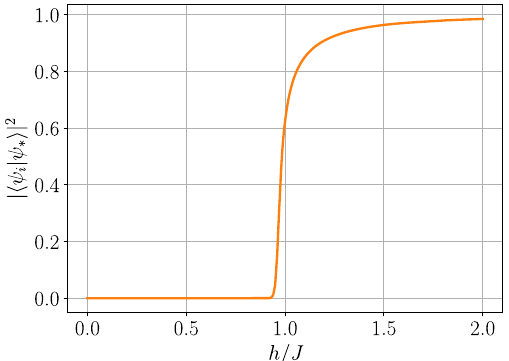
FIG. 4. LMG model: overlap between the initial state j ψ i i and the target state j ψ i , which is vanishingly small in the ferro- (cid:2) magnetic phase h=J ≪ 1 and motivates the parameter choice for the target state. In the vicinity of the critical point, the overlap increases and approaches unity in the limit h=J → ∞ . Note that, in the FM phase, the ground state is doubly degenerate, in which case the overlap is computed with respect to the ground-state 1 Þ 2 þ jh ψ 2 . In the paramagnetic phase, ψ ð 2 Þ manifold: jh ψ i j ψ ð i j (cid:2) ij (cid:2) ij the ground state is unique. We use N ¼ 501 spins.